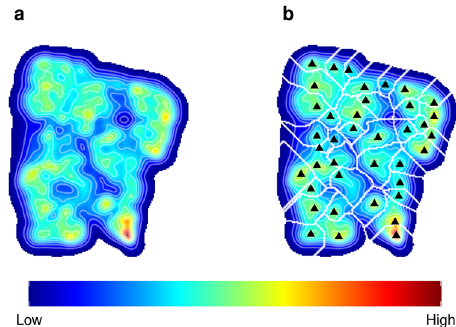
Fig. 1 Sperm motility landscape resulting from a (Barnes-Hut approximation) t-SNE dimensional reduction. a Kernel density showing the high- and low-density regions within the landscape, computed in a 200 × 200 cell grid with a neighbouring parameter representing a 1% of the dataset size (perplexity = 639). b Clustering using a watershed algorithm allowing the discretization of data into clusters (delimited by the white lines), and depicting the highest density peak within each cluster (black triangles). The legend describes the colour gradient in the density kernel. This analysis involves functions "bdm.pakde" and "bdm.wtt" in the bigMap R package. See also "Sperm motility landscape" in Methods and Garriga & Bartumeus 2018 75